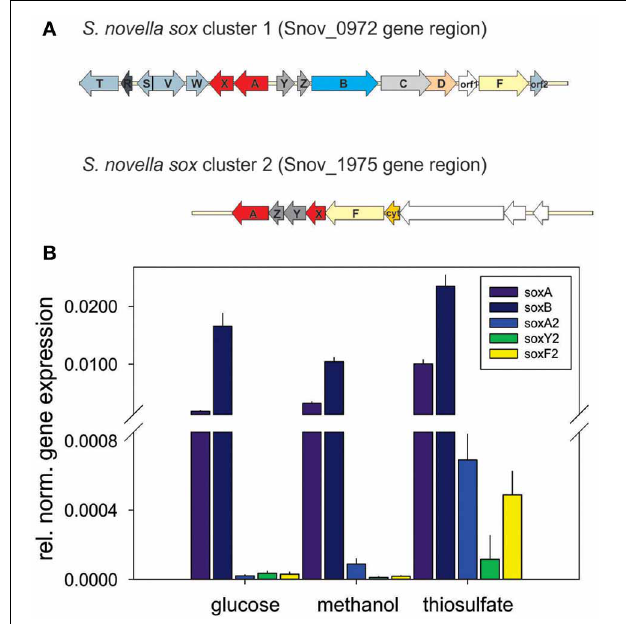
FIGURE 2 | Genes involved in dissimilatory sulfur oxidation in S. novella . (A) Schematic representation of the two sox gene clusters encoded in the S. novella genome. soxAX , red; soxYZ , dark gray; soxB , light blue; soxC , light gray; soxD , orange; soxF, yellow; accessory genes (e.g., soxV,W,S etc.), blue gray; soxR , dark blue gray; orf1 membrane anchor protein (main sox cluster) and Xanthine Oxidase family Mo enzyme (second sox cluster), no fill. (B) Expression of sox genes in S. novella cultures grown in the presence of glucose, methanol, or thiosulfate/CO 2 . Error bars represent the Standard Deviation of the mean, gene expression was normalized relative to the expression of the 16S RNA gene. A number “2” added to the gene name denotes that this gene is present in the second sox gene cluster.